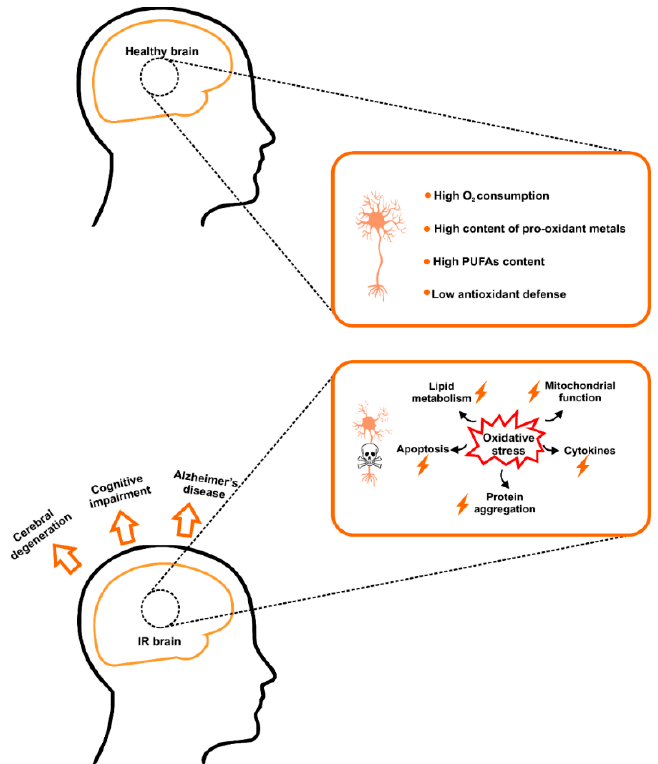
Figure 1. The brain as a specific target for insulin resistance and oxidative stress. The brain is particularly sensitive to the free radical attack due to its increased oxygen consumption, limited antioxidative mechanisms, as well as high levels of polyunsaturated fatty acids (PUFAs). In IR brain, overproduction of reactive oxygen species (ROS) leads to oxidative damage associated with ATP depletion, activation of pro-inflammatory cytokines, accumulation of protein aggregates, as well as neuronal apoptosis. Abbreviations: IR, insulin resistance; PUFAs, polyunsaturated fatty acids.